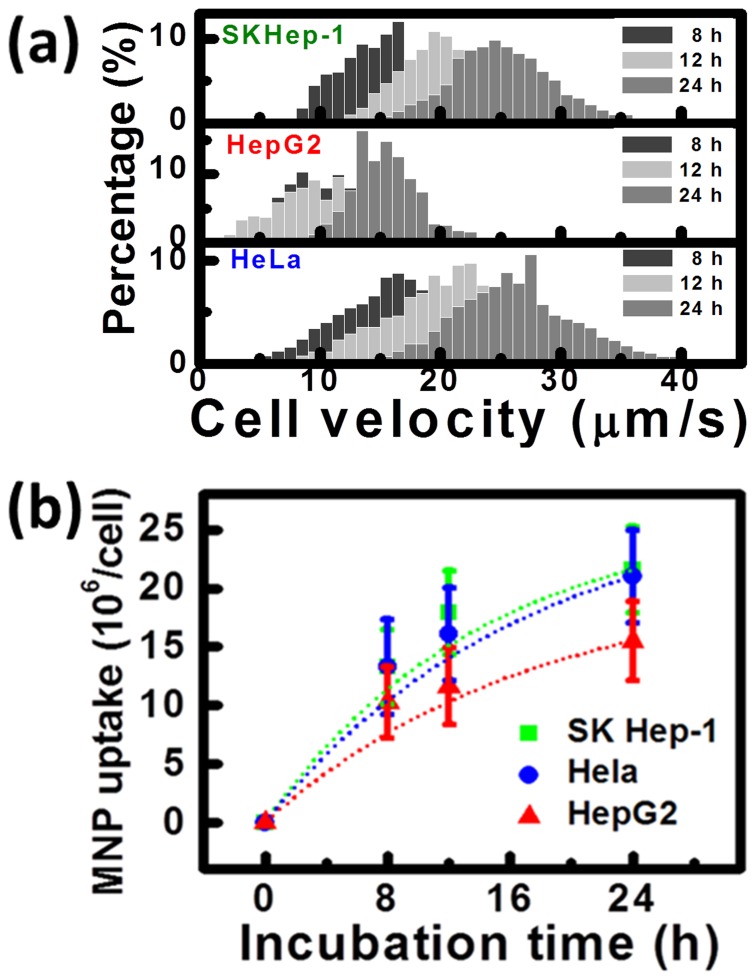
Quantitative analysis of magnetic nanoparticle (MNP) monitored as a function of the incubation time.(a) The distributions of magnetophoretic velocity of cells incubated with magnetic nanoparticles for 8, 12, 24 h. N = 1000. (b) The cell loading with MNPs after incubating for 8, 12 and 24 h. Dot lines represent the exponential fit of the data. Bars represent the standard deviation of 500 different cells.